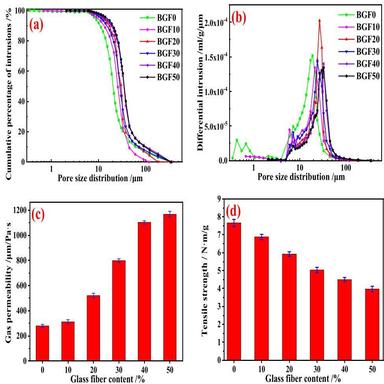
The MIP curves of (a) different and (b) cumulative intrusion for all the samples; Effect of glass fiber addition on (c) the gas permeability and (d) strength property of the core material.